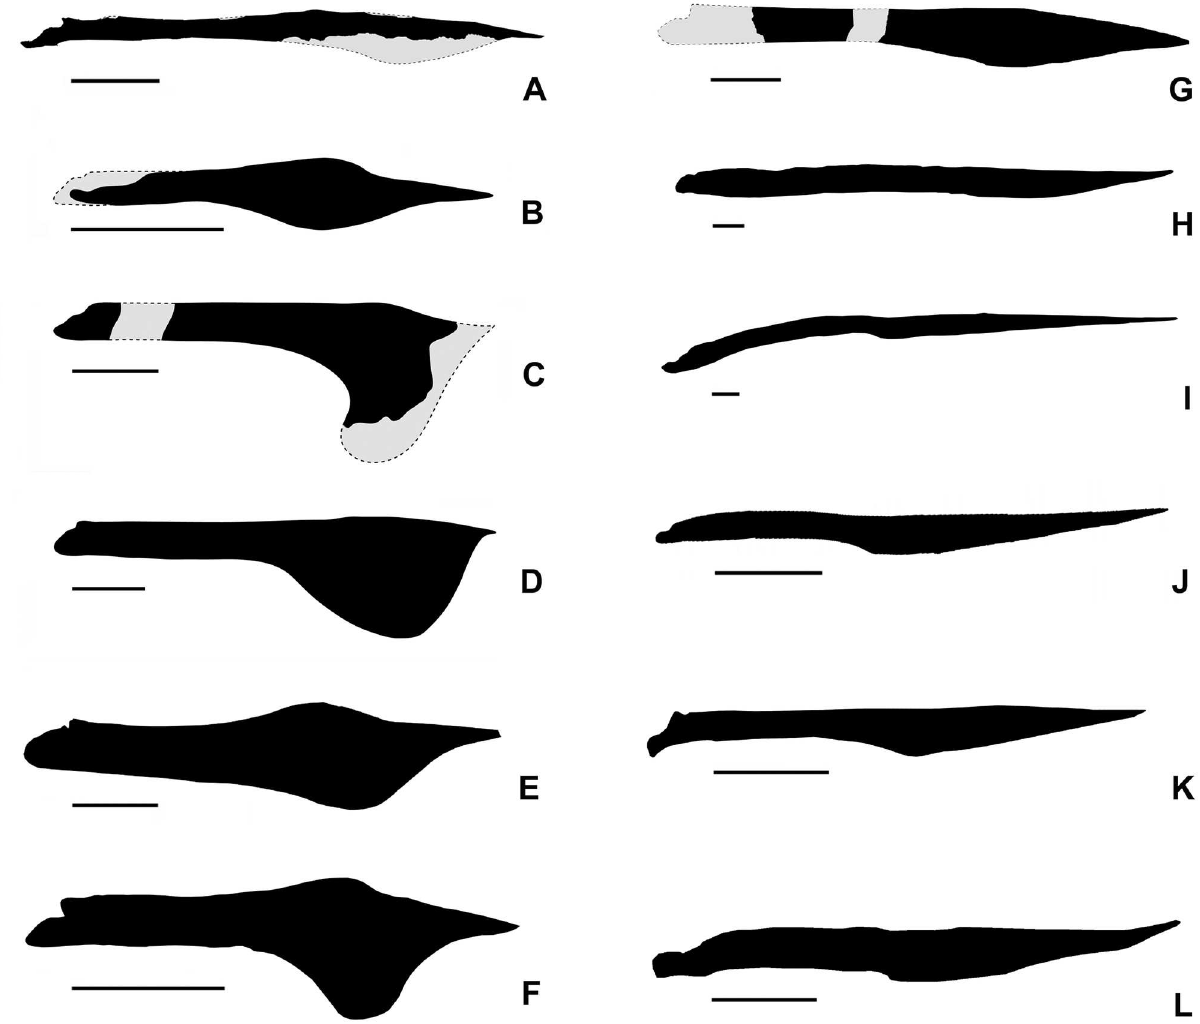
Fig 3. Comparison of azhdarchoidmandibles (rightlateralview). (A) Aymberedactyluscearensis gen. et sp. nov. (MN 7596-V).(B) Sinopterusdongi (GMN-03-11-001,holotype of “ Huaxiapterus jii ”, based on [8, 46]).(C) Europejaraolcadesorum (MCCM-LH 9413, based on [8]).(D) Tupandactylus imperator (CPCA 3590, based on [8, 28]. (E) Caiuajaradobruskii (CP.V 1005a,based on [7]).(F) Tapejara wellnhoferi (IMNH1053, based on [13]).(G) Caupedactylusybaka (MN 4726-V; based on [6]).(H) Tupuxuara leonardii (IMCF1052, based on [3]).(I) Quetzalcoatlus sp. (TMM42161–2, based on [42]).(J) Zhejiangopteruslinhaiensis (M 1330,based on [41]).(K) Shenzoupterus chaoyangensis (HGM41HIII-305A, based on [43]).(L) Chaoyangopterus zhangi (LPM-R00076, based on [52]).All scales are 50 mm in